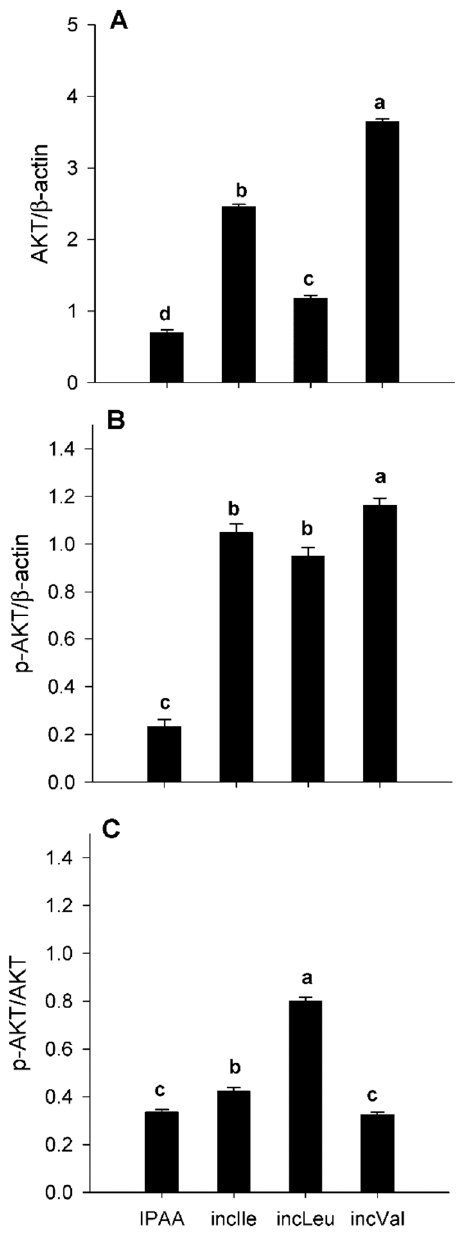
Figure 1. Protein abundance (relative to β -actin) of protein kinase B (AKT; total, panel ( A )), p-AKT (active, panel ( B )), and ratio of p-AKT/AKT (panel ( C )) in s.c. adipose tissue cultured with different levels of Leu, Ile, or Val. Control media contained an ideal AA profile (IPAA; Lys:Met 2.9:1, Lys:Val 1.23:1; Lys:Ile 1.45:1; Lys:Leu 0.85:1). Treatment media was supplemented with greater amounts of Leu, Ile, or Val to achieve ratios of Lys:Leu 0.78:1 (incLeu), Lys:Ile 1.29:1(incIle), or Lys:Val 1.12:1 (incVal). Different letters indicate differences between treatments ( p < 0.05) using the Tukey multiple comparison procedure in SAS v.9.4 (SAS Institute Inc., Cary, NC, USA). Data are LS means, n = 4 cows per group, ± pooled SEMs.